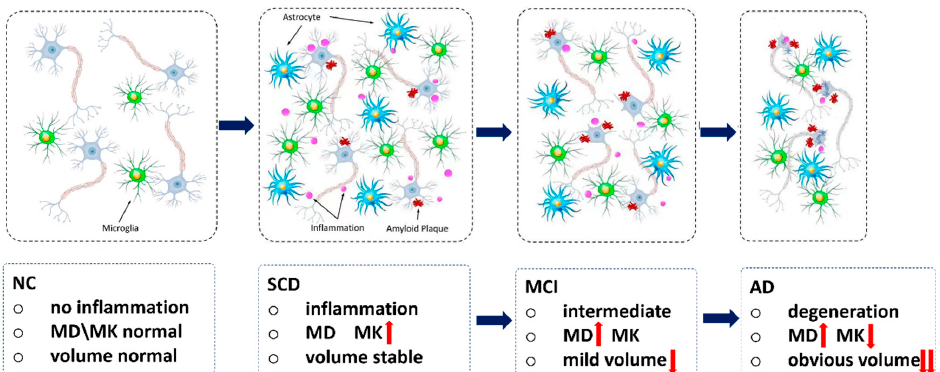
Figure 7. The assumptions of pathological changes in AD spectrum. In SCD stage, the amyloid plaque and other risk factors might trigger the inflammatory process associated with increased microglia and astrocytes. These pathological processes eventually lead to increased cellular density and microenvironment complexity in hippocampal tissues, so the MK would increase. In MCI stage, the expanded extracellular space (due to the axonal and neuronal loss) outweighed the inflammation, so the water diffusion was not hindered but increased, and MD was increased. In AD stage, brain atrophy (neurodegeneration or neuronal body loss) will be predominant. AD = Alzheimer’s disease; SCD = subjective cognitive decline. We plotted this figure by ourselves. The ascending red arrow represents increase; the descending red arrow represents